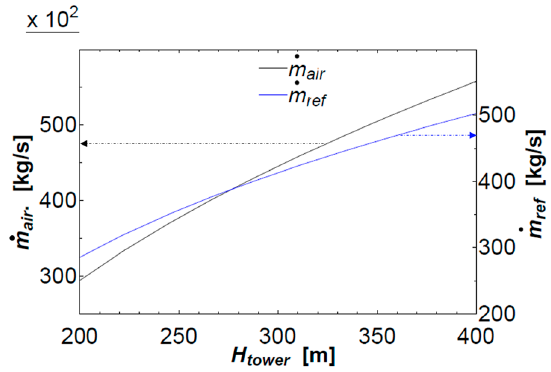
Figure 7. Air and refrigerant mass flow rate change with tower height.